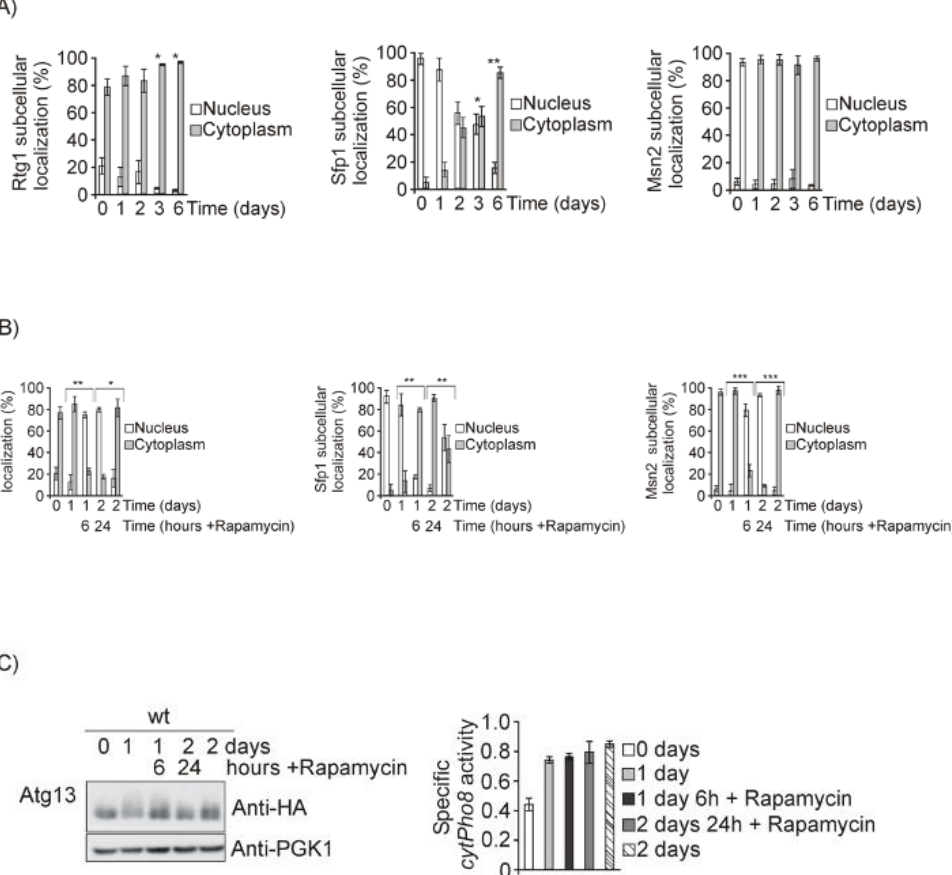
Figure 2. TORC1 is not inactivated during diauxic and posdiauxic shifts. ( A ) wt strains transformed with the plasmids Rtg1GFP, Sfp1GFP, or Msn2GFP respectively, were grown at 30 ◦ C in SD media for the times indicated in the figures. Aliquots were collected for in vivo observation in the fluorescence microscope. Histograms represent the percentages of in vivo nuclear or cytoplasmic localization out of more than 1000 cells. ( B ) Cultures in A were treated with rapamycin (200 ng/mL) on day one of culture for 6 h and aliquots were collected for in vivo observation in the fluorescence microscope. Histograms are performed as in ( A ). ( C ) A wt strain expressing Atg13HA was exponentially grown at 30 ◦ C in SD media. Rapamycin was added to the culture upon one day of growth at 200 ng/mL and samples were collected upon 6 and 24 h of exposure to the drug for total protein extraction, Western blot analysis, and identification of Atg13HA using anti-HA antibody. Autophagic enzymatic activity was determined through the alkaline phosphatase assay, as in (Figure 1A). Error bars in the histograms represent the standard deviation (SD) calculated from three independent experiments. Significance of the data was determinate by p -values from a Student’s unpaired t -test denoted as follows: * = 0.05 > p > 0.01; ** = 0.01 > p > 0.001; *** = 0.001 > p >